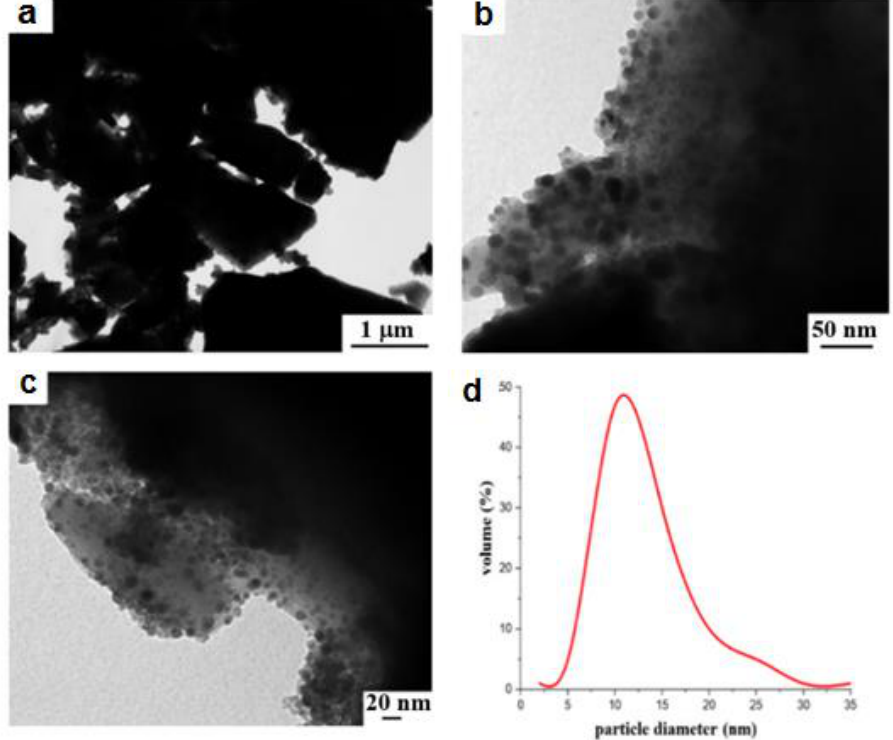
Figure 8. ( a – c ) TEM images and ( d ) particle size distribution curve of sample 1a . Heating of 2 , as in the case of 1 , leads to the destruction of its crystal structure and the formation of a two-component system consisting of large blocks and nanosized particles crystallized on their surface (Figure 9).